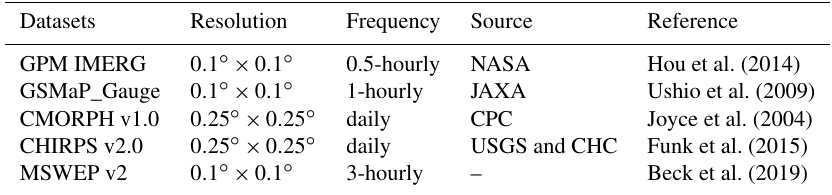
Table 1. Multiple-satellite precipitation datasets used in this study.